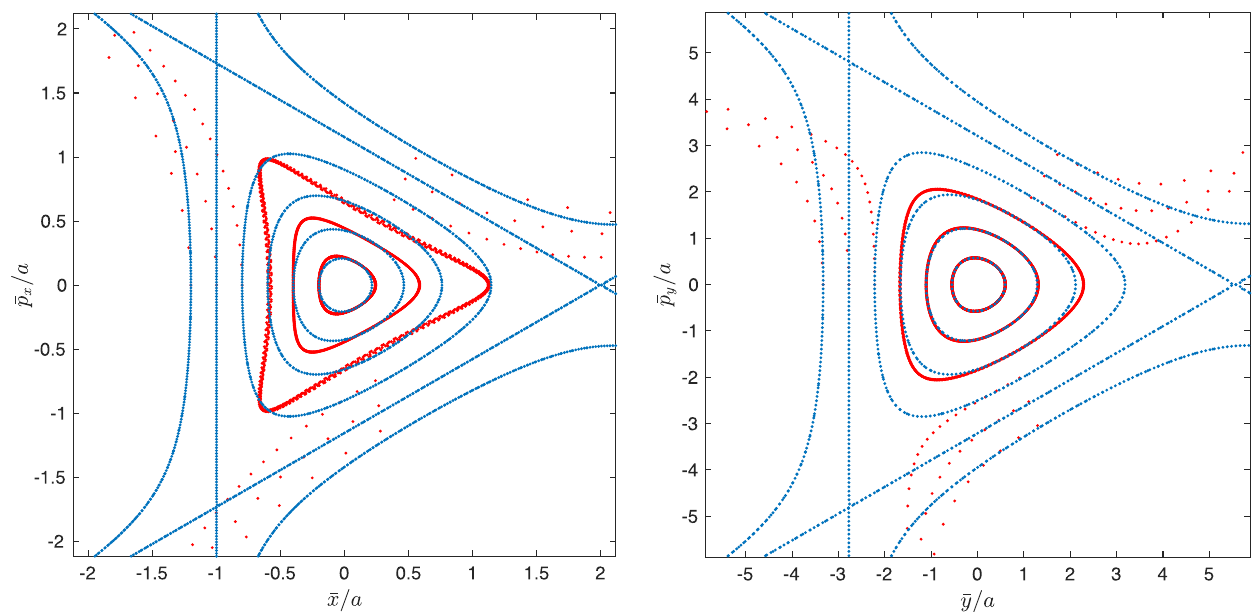
FIG. 11. A second set of invariant tori inside the separatrix in the 4D phase spaces near 1 = 3 resonance with a deviation of Δ ν ¼ 0 . 005 . The red dots represent the orbits from tracking with cell length L ¼ 15 m and angle ϕ ¼ π = 96 and the blue lines are the contours derived from the Hamiltonian in Eq.